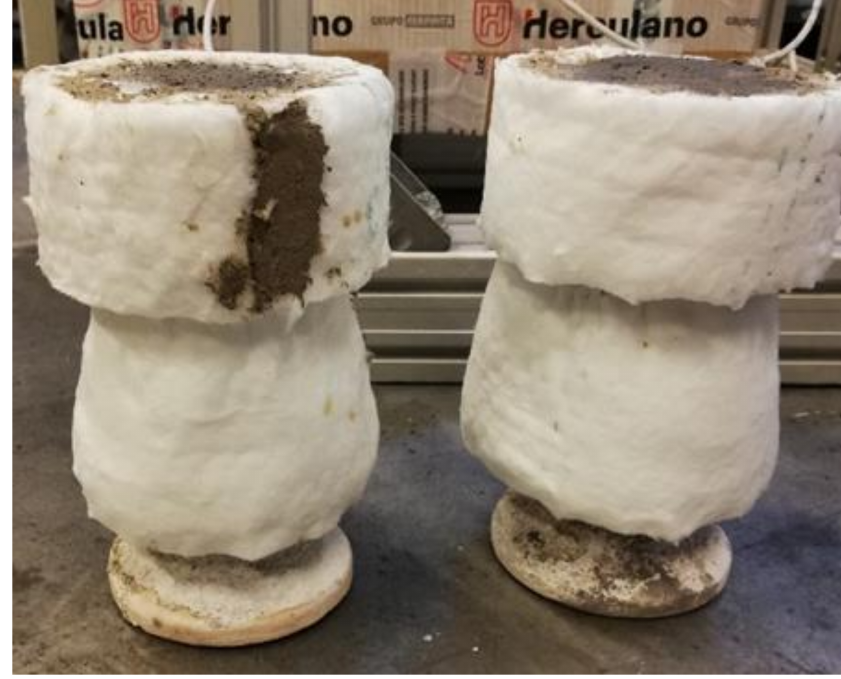
Figure 9. Thermal blanket applied around ceramic shell.